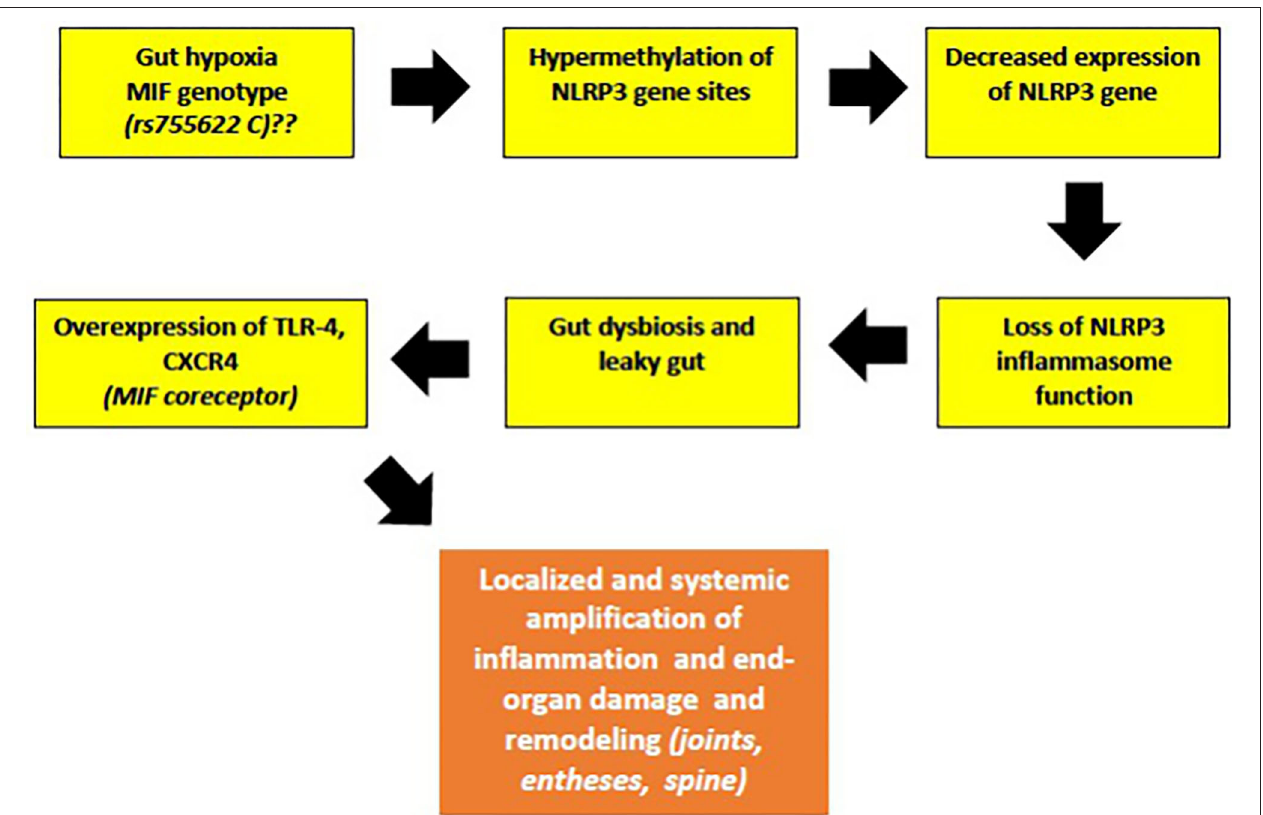
FIGURE 2 | The malfunction of NLRP3 inflammasome, a key tissue damage sensor, plays an important role in various autoinflammatory and autoimmune diseases. Proposed hypothesis of decreased NLRP3 gene expression and possible role of MIF in the early phases of jSpA development (see text for description).